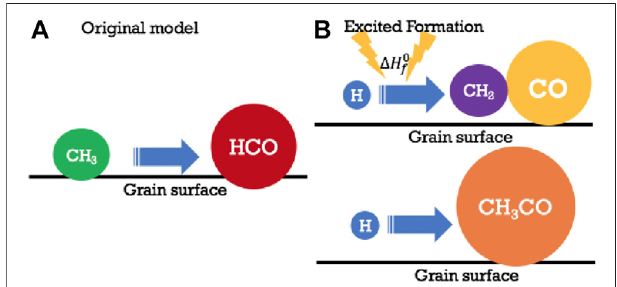
FIGURE 5 | Several other mechanisms involving diffusive and nondiffusive formation mechanisms on grains. In (A) , a simple diffusive reaction involving radicals CH 3 and HCO leads to acetaldehyde, albeit slowly atlowtemperatures.In (B) onceagainHandCH 2 produceCH 3 ,whichin this case has suf fi cient energy from the exothermic process to react with a neighboring CO molecule to form CH 3 CO, which can easily be hydrogenated with H atoms via diffusive reaction to form CH 3 CHO. Permission given to reproduce this fi gure, originally appearing as Figure 1 in Jin and Garrod. (2020), by IOP